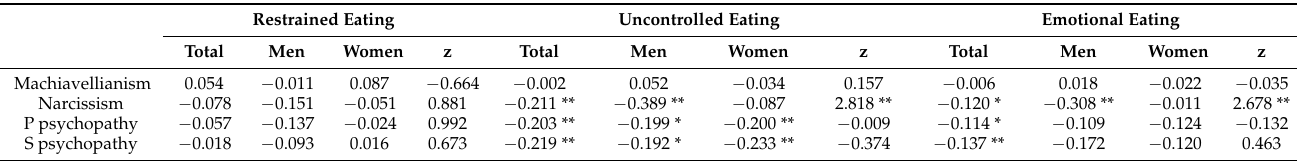
Table 2. Correlations between Dark Triad and all variables by